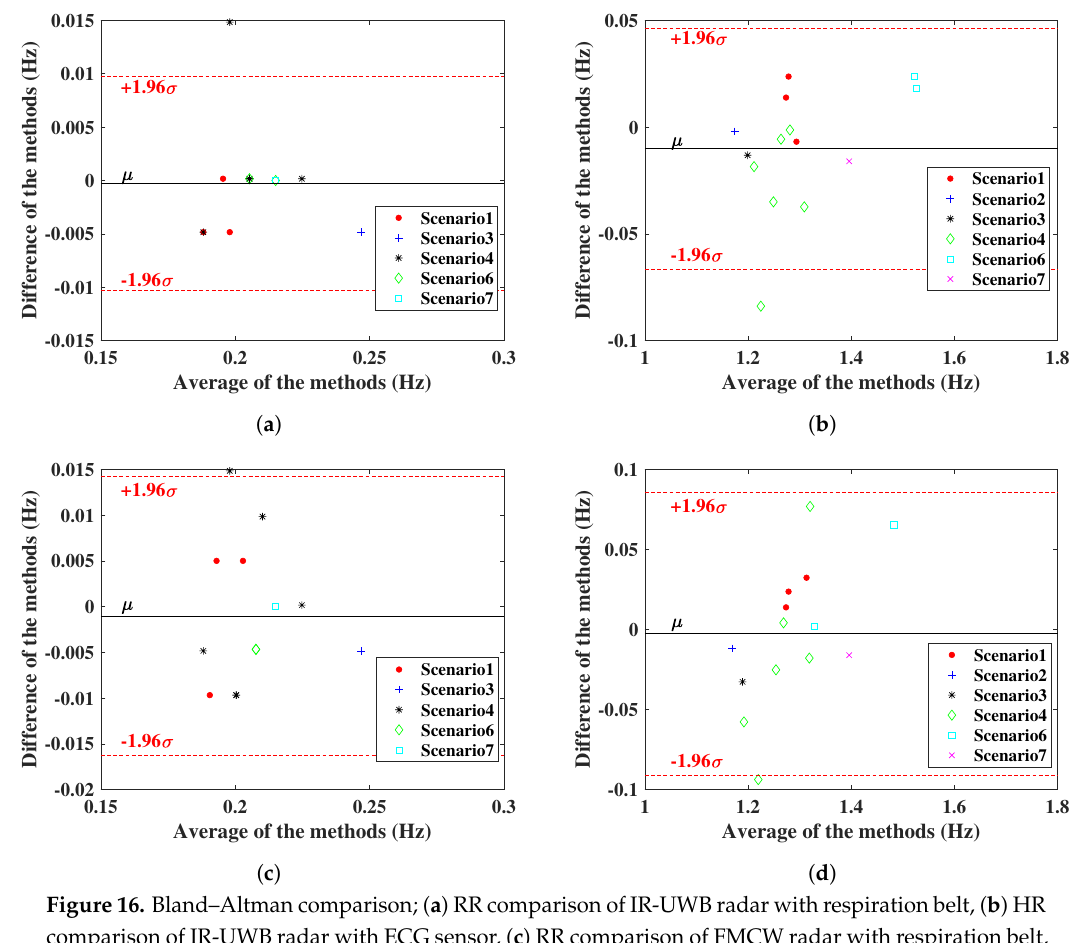
Figure 16. Bland–Altman comparison; ( a ) RR comparison of IR-UWB radar with respiration belt, ( b ) HR comparison of IR-UWB radar with ECG sensor, ( c ) RR comparison of FMCW radar with respiration belt, ( d ) HR comparison of FMCW radar with ECG sensor. The red lines define the limits of the confidence interval ( µ ± 1.96 σ ), and the black line refers to the mean ( µ ) in the